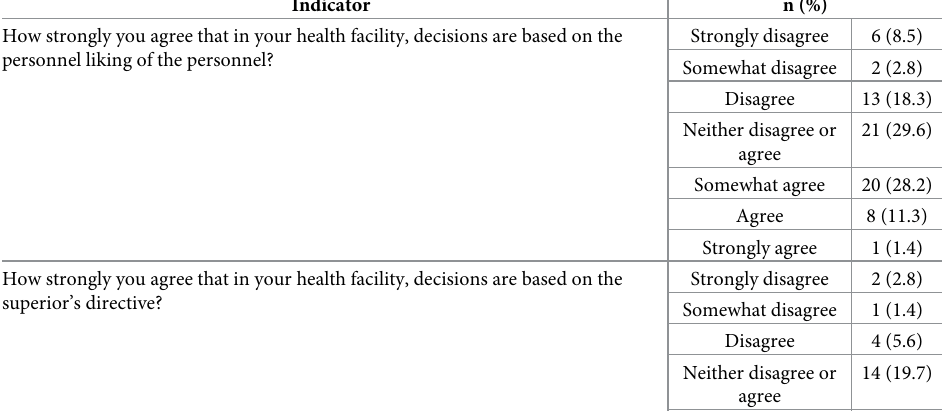
Table 4. Decision making regarding management of health information system.